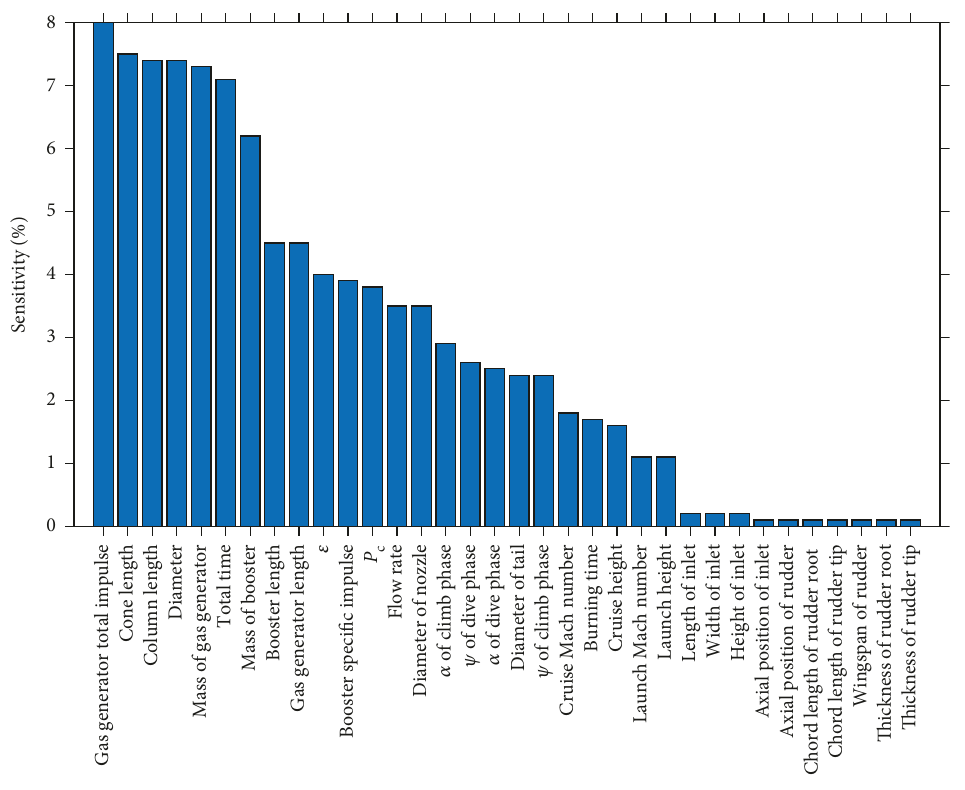
Figure 10: Sensitivity analysis.